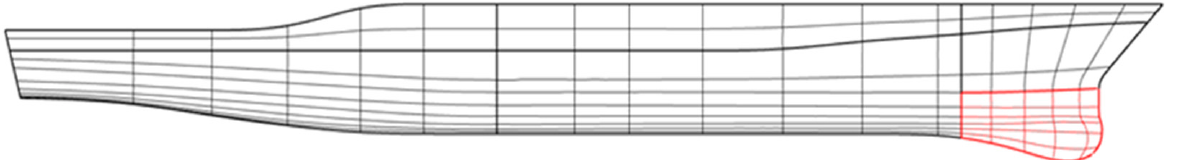
Figure 1. Ship model ( side view ). The red lines indicate the sonar dome.